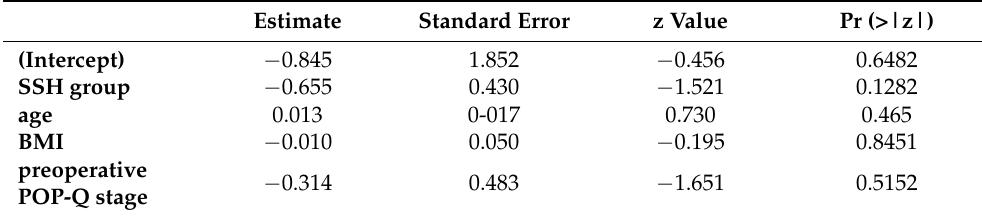
Table 4. Logistic regression. Postoperative complications in the whole collective depending on the deviances: 146.44 for the null model vs. for the full 143.06